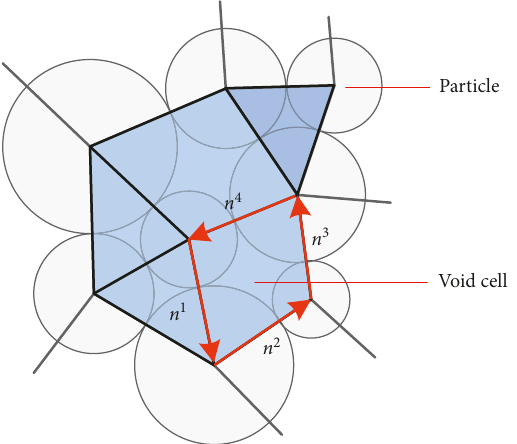
Figure 10: Void-based microscopic representation of